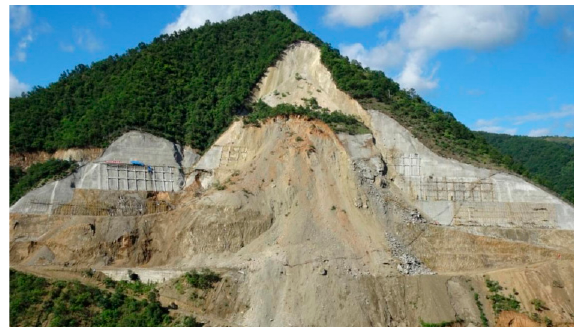
Figure 2. slope collapse. Figure 2. Slope